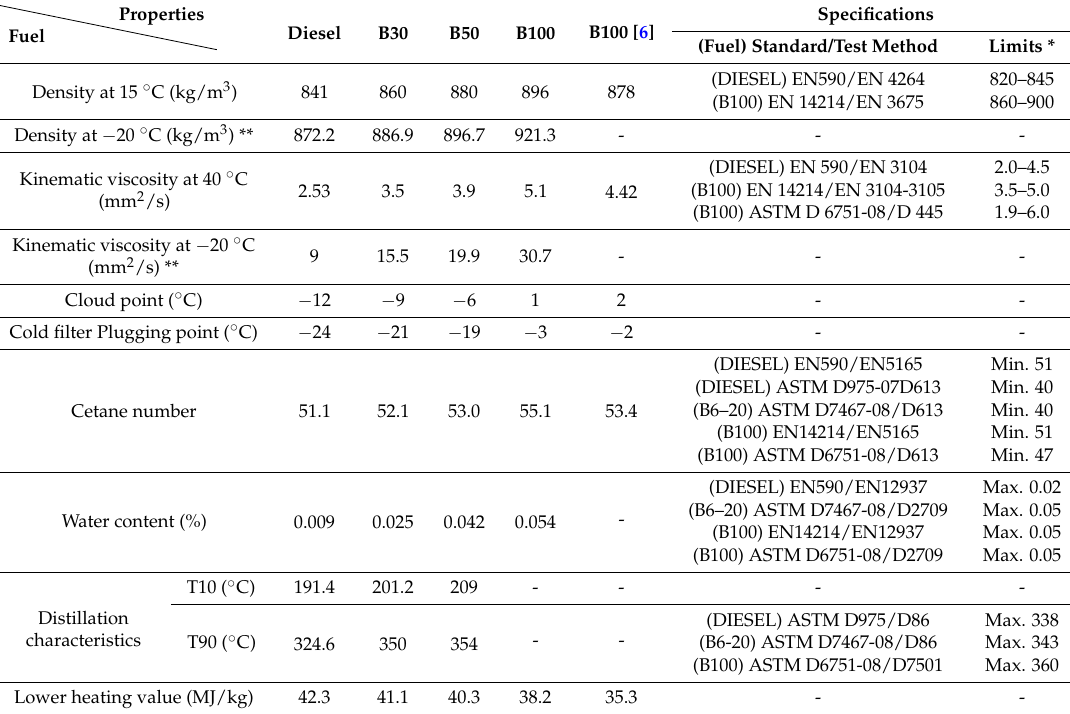
Table 1. Characteristics of the fuels used in the